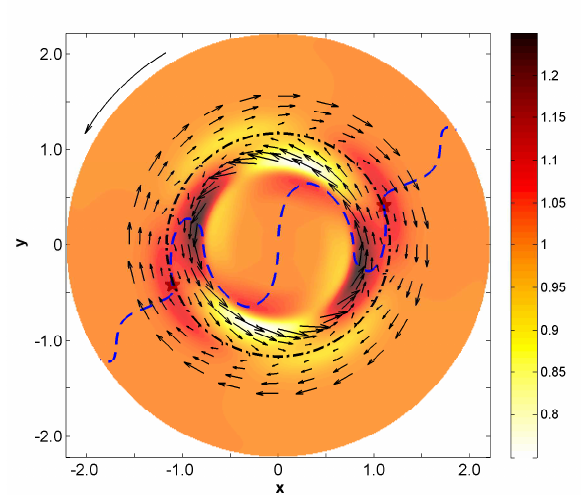
Figure 6. The same eigenfunction σ 1 ( r , φ ), as on Figure 5, in usual representation. The corotation circle is indicated by a bold black dot-dashed line, the phase curve – by blue dashed line. The arrows represent the perturbed vector velocity field in the coordinate frame of the wave, red stars denote centers of anti-cyclones, large arrow to the north-west indicating the direction of the disk rotation. The outer part of the disk is cut off, where the perturbation amplitude decreases quite